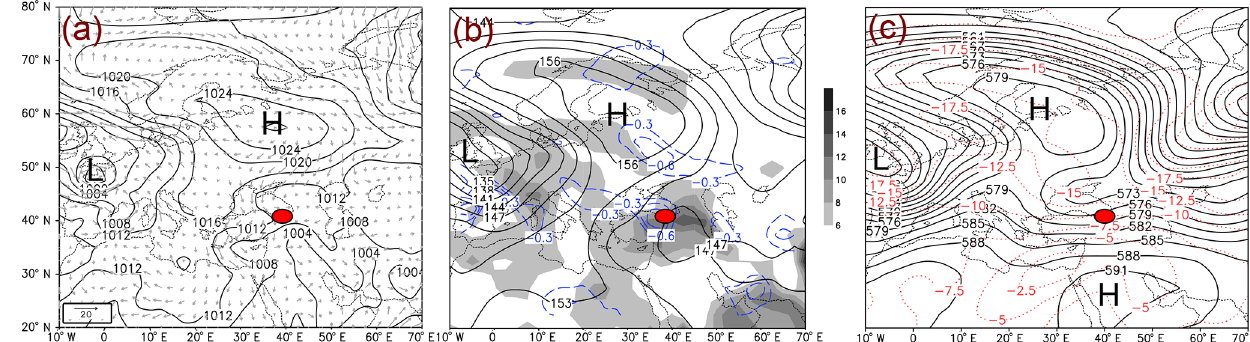
Figure 6. (a) Same as Fig. 5a, (b) same as Fig. 5b, (c) same as Fig. 5c, but for 24 August 2015, 06:00UTC.